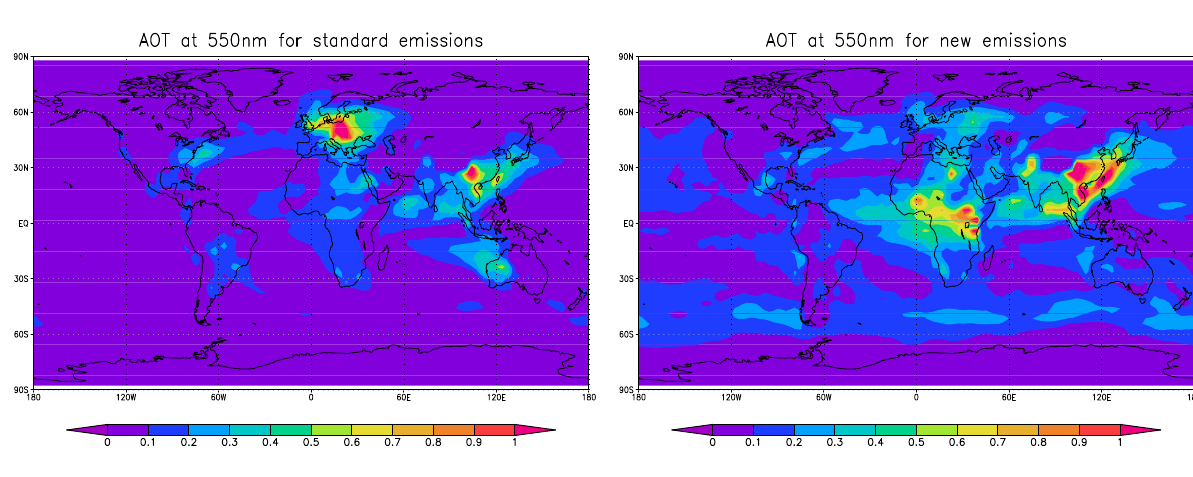
Figure 3. Global AOT (averaged over 9–30 January) for forecast runs with either the standard or new emissions.